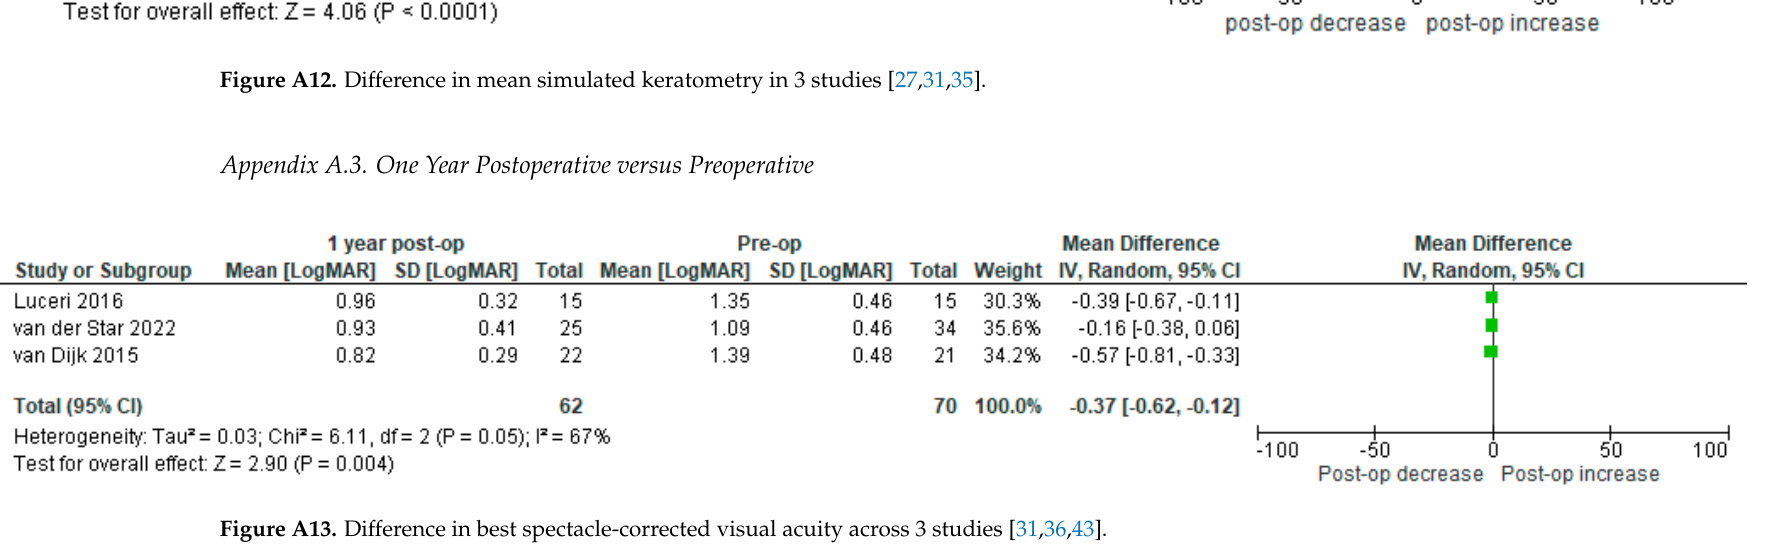
Figure A14. Di ff erence in best contact lens-corrected visual acuity across 3 studies [31,36,43].